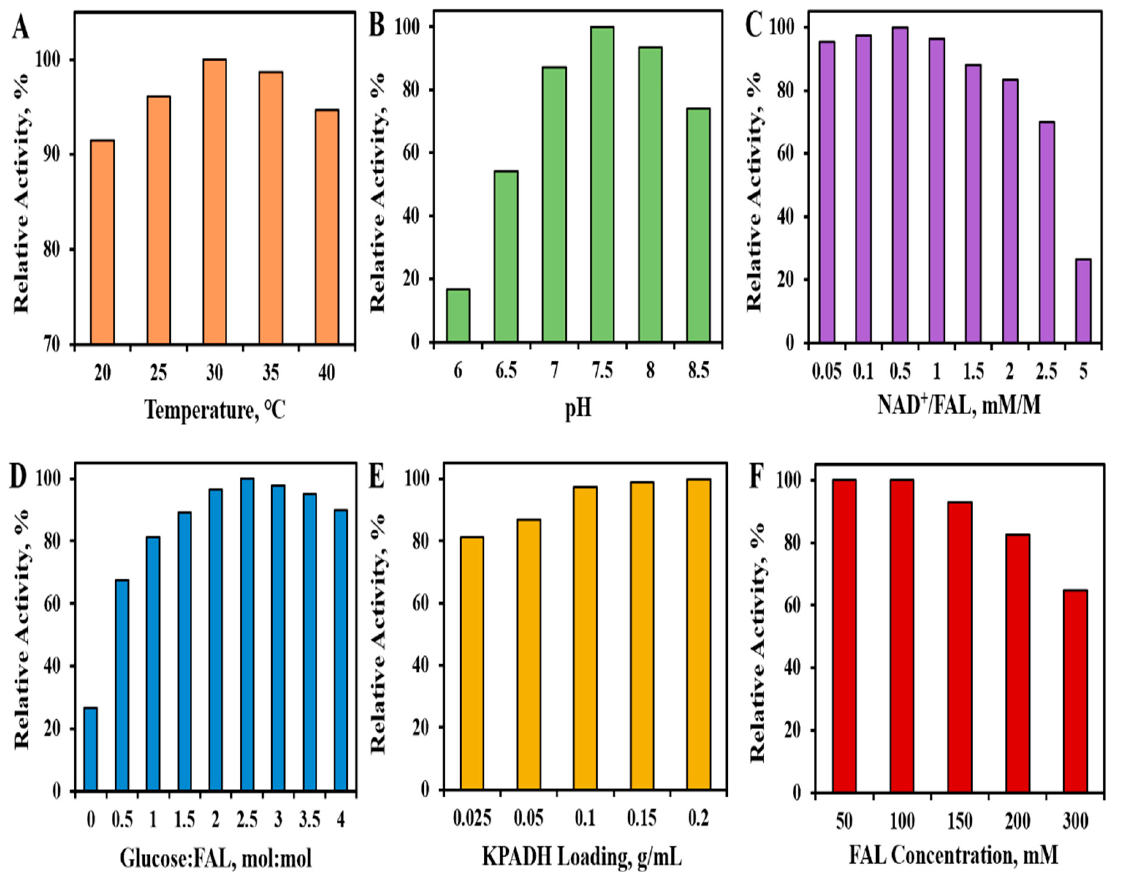
Figure 7. ( A ) Effects of bioreduction temperature (20–40 °C) on the FAL-reducing activity (FAL 100 mM, pH 7.5, NAD + /FAL 0.5:1 (mmol:mol), glucose/FAL 2.5:1 (mol:mol), KP ADH cell wet weight 0.1 g/mL); ( B ) effects of bioreduction pH (100 mM KH 2 PO 4 -K 2 HPO 4 buffer, pH 6.0–8.5) on the FAL-reducing activity (FAL 100 mM, 30 °C, NAD + /FAL 0.5:1 (mmol:mol), glucose/FAL 2.5:1 (mol:mol), KP ADH cell wet weight 0.1 g/mL); ( C ) effects of NAD + load (NAD + to FAL molar ratio, 0.05–5:1, mmol: mol) on the FAL-reducing activity (FAL 100 mM, 30 °C, pH 7.5, glucose/FAL 2.5:1 (mol:mol), KP ADH cell wet weight 0.1 g/mL); ( D ) effects of glucose load (glucose to FAL molar ratio, 0–4:1 mol: KP ADH cell wet weight 0.025–0.2 g/mL); ( E ) effects of cell biocatalyst load (0.025–0.20 g/mL) on the FAL-reducing activity (FAL 100 mM, 30 °C, pH 7.5, NAD + /FAL 0.5:1 (mmol:mol), glucose/FAL 2.5:1 (mol:mol)); ( F ) effects of FAL concentration (50–300 mM) on the FAL-reducing activity (30 °C, pH 7.5, NAD + /FAL 0.5:1 (mmol:mol), glucose/FAL 2.5:1 (mol:mol), KP ADH cell wet weight 0.1 g/mL).